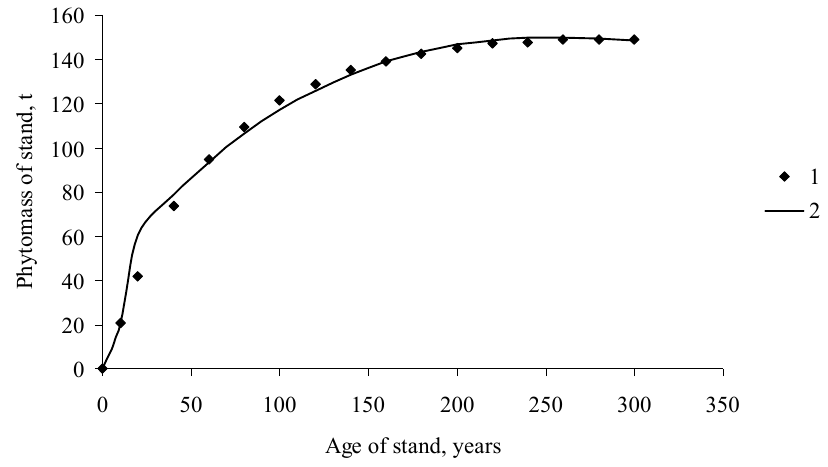
Figure 2. Dynamics of the forest stand phytomass, including root phytomass of Larix gmelinii Rupr., Middle Siberia, ( 1 ) field data ([10], p. 589); ( 2 ) EcoSolow model calculations.